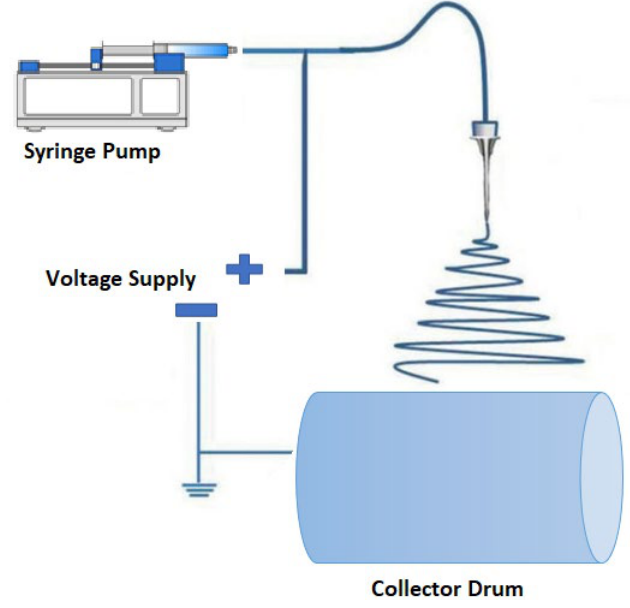
Figure 2. Electrospinning process for PLA nanofibers.